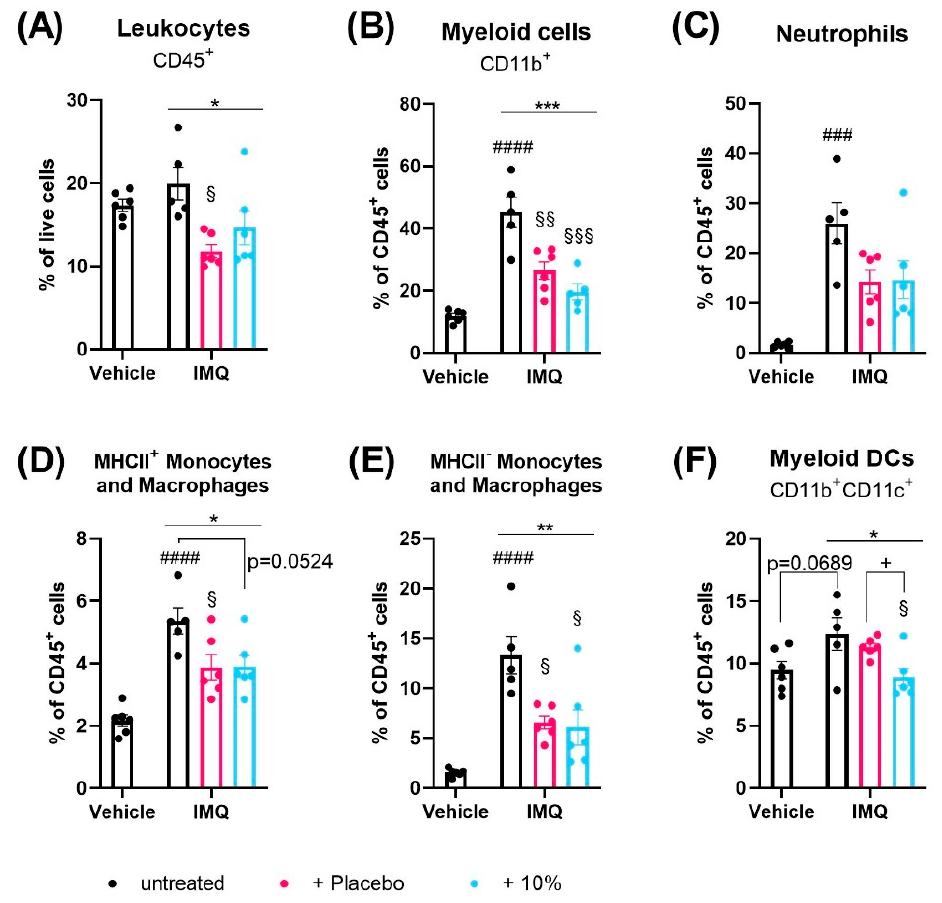
Figure 4. Diacerein affects skin immune cell populations in IMQ-induced psoriasis. Flow cytometric analysis of CD45 + leukocytes ( A ), CD11b + myeloid cells ( B ), neutrophils ( C ), MHCII + ( D ) and MHCII - ( E ) monocytes and macrophages, and CD11b + CD11c + myeloid dendritic cells (DCs) ( F ) in skin single cell suspensions in mice on day 4 after receiving treatment for 3 consecutive days. Psoriasis was induced by daily topical application of 80.0 mg Aldara ® (IMQ) to the dorsal skin. Following IMQ, mice were treated with 100 mg of 10% diacerein or placebo or the skin was left untreated. Control mice received vehicle cream. Data represent means ± SEM. n = 5–6 per group. ### p < 0.001, #### p < 0.0001, unpaired t -test, vehicle vs. untreated IMQ; * p < 0.05, ** p < 0.01, *** p < 0.001, one-way ANOVA, IMQ groups only; § p < 0.05, §§ p < 0.01, §§§ p < 0.001, Tukey’s multiple comparison test, vs. untreated IMQ; + p < 0.05, unpaired t -test: as